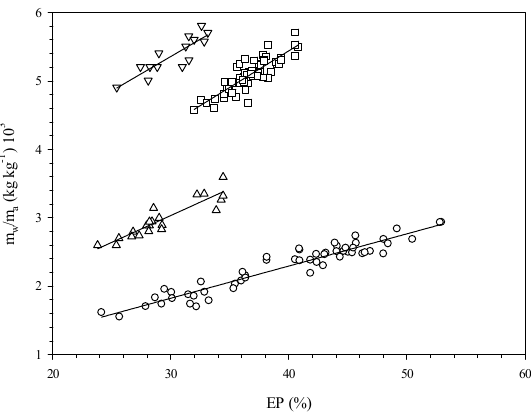
Figure 6. Relationship between the specific water consumption (m w / m a (kg kg − 1 ) 10 3 ) and the EP (%) as a function of the HR value of the outdoor air (75%, ○ ; 60%, △ ; 45%, □ ; and 30%, ▽ ). Table 3. Slope values (A) and the ordinate origin (B) of the linear regressions between the specific water consumption (m w / m a (kg kg − 1 ) 10 3 ) and the EP (%) for di ff erent outdoor RH values (RH o ). The determination coe ffi cient value, R 2 , and its statistical significance (***, p < 0.0001) are also indicated.